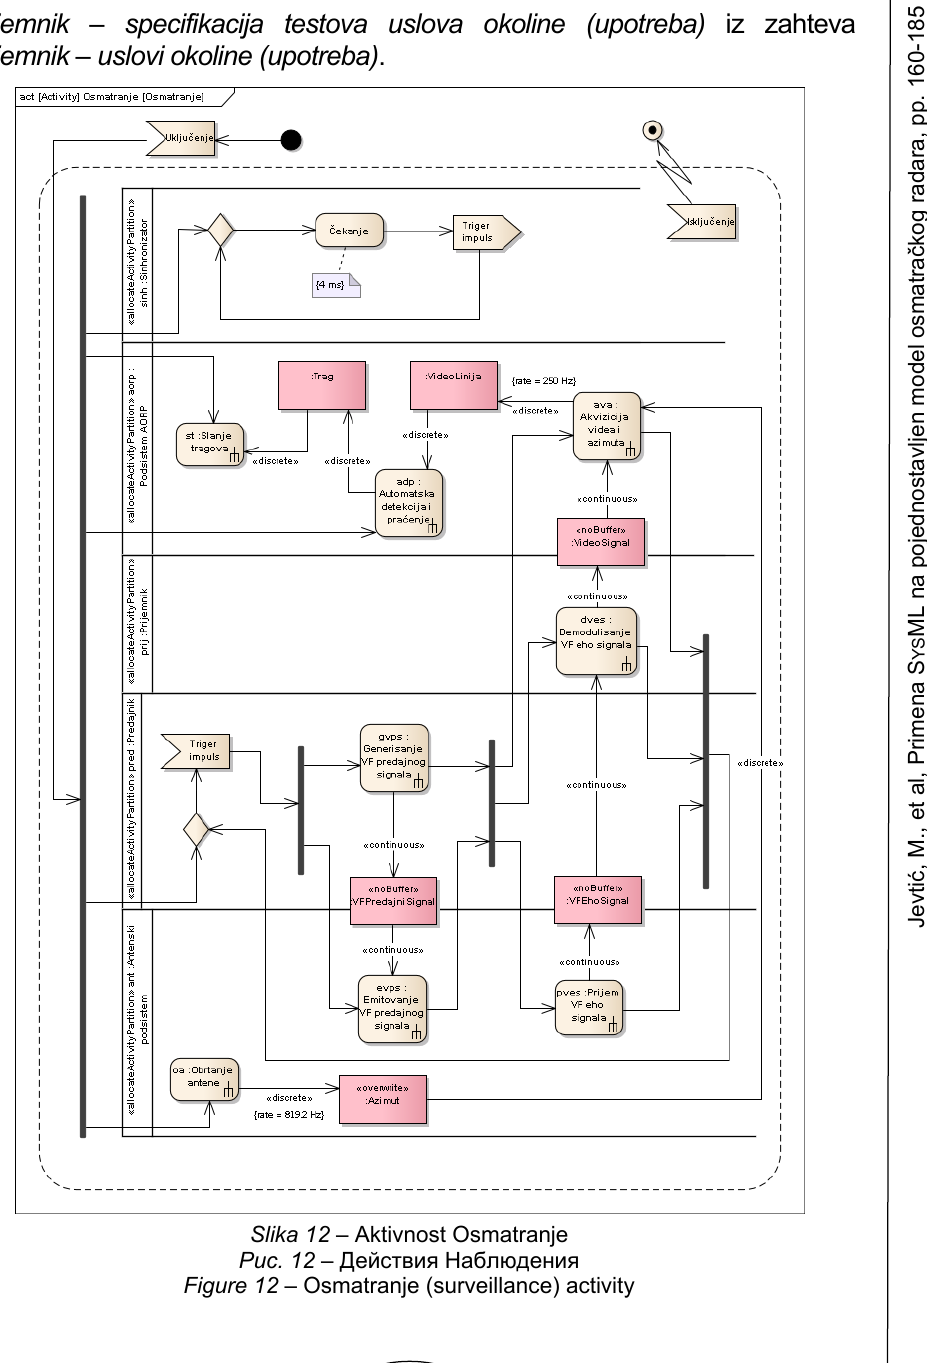
Figure 12 – Osmatranje (surveillance)